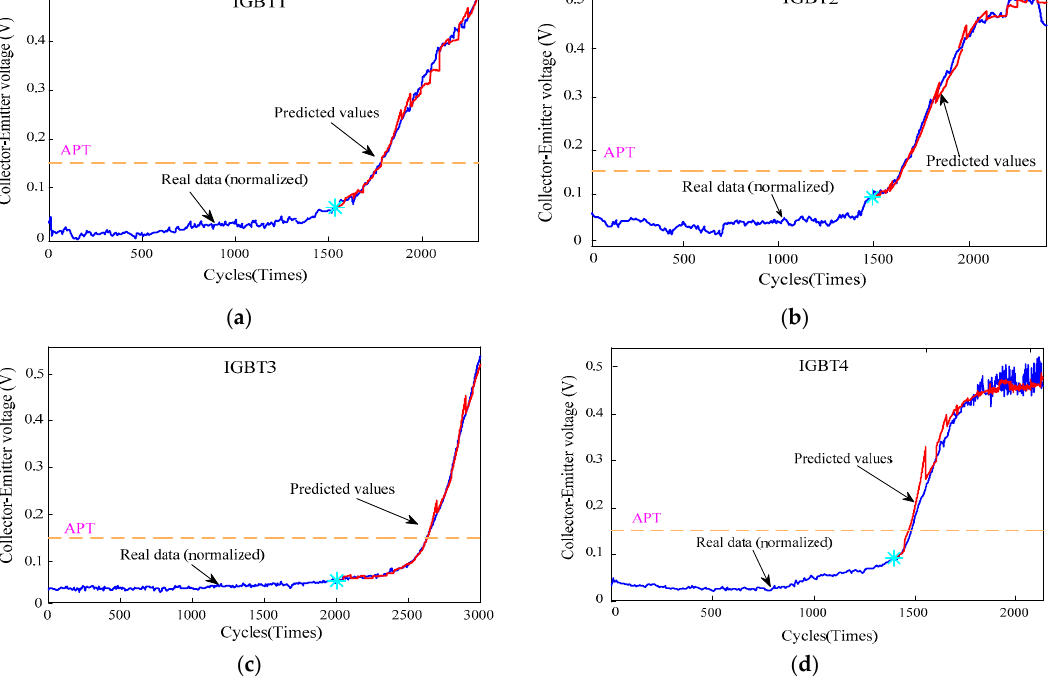
Figure 9. IGBT experimental data (IGBT3) entropy ratio diagram. When the parameter design of the VKOPP algorithm is completed, the forecasting process will be carried out (the specific steps are shown in Section 4 of this paper). To better validate the prediction performance of our proposed prognostic approach, three experiments with different experimental conditions are conducted: (1) use the different numbers of measurement data points as the training data to predict the RUL under the same forecast steps; (2) take two-thirds in each IGBT experimental dataset for the training set to predict the RUL under the different forecast steps; (3) compare the VKOPP algorithm with other typical machine learning algorithms to predict the IGBT RUL in terms of prediction accuracy and time consumption. Table 6. The Life prediction error result foreach IGBT experimental dataset at different training cycles (50-step-ahead). Cycle Test Conditions